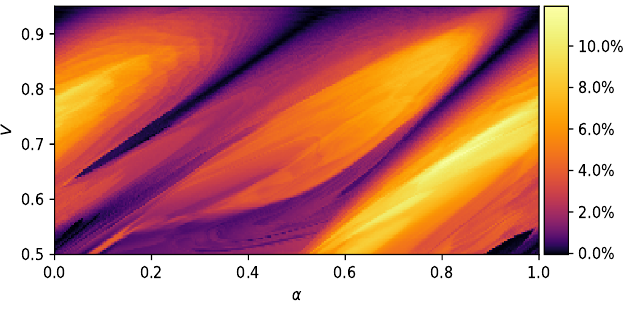
Figure 30 . Fraction of the total energy of the initial con(cid:12)guration carried out by the radiation for v = 0 : 45.